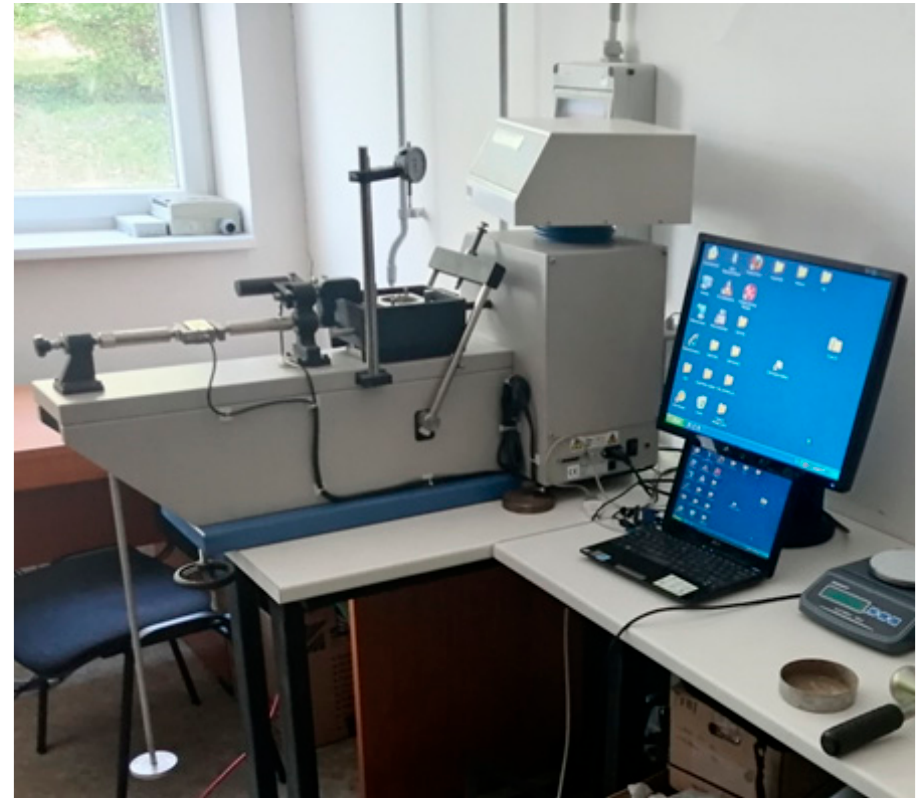
Figure 2. Direct shear test machine (ELE 26-2112/01).